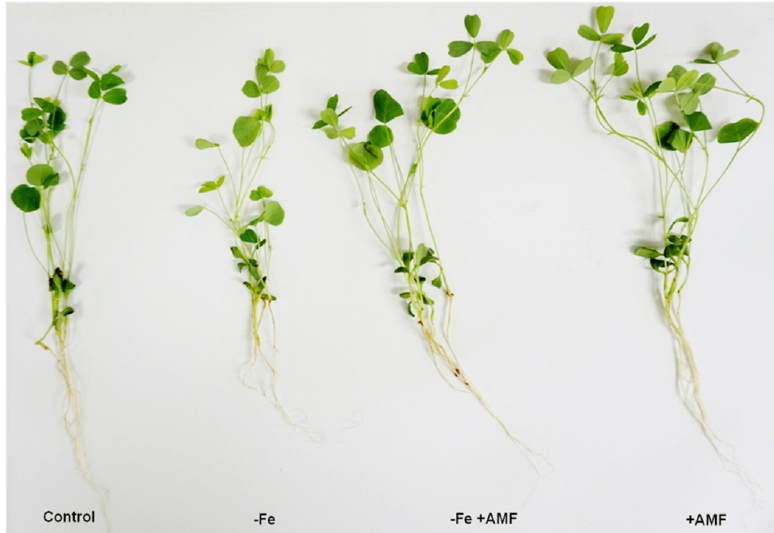
Figure 1. Changes of alfalfa phenotype. Fe deficiency ( − Fe)-induced chlorosis, along with role of Arbuscular mycorrhizal fungi (AMF) to alleviate Fe deficiency retardation in alfalfa. Photograph of alfalfa plants were taken after 4 weeks of treatment.